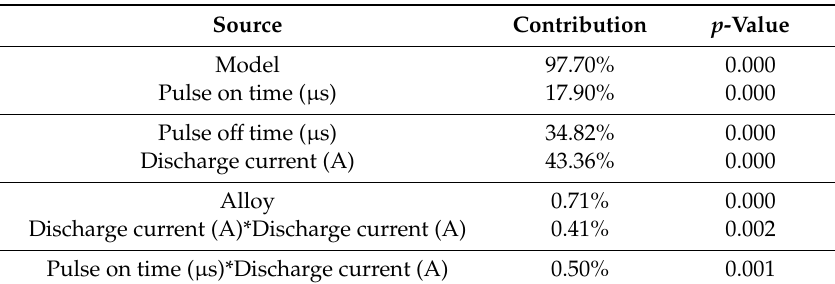
Table 4. Contributions of individual